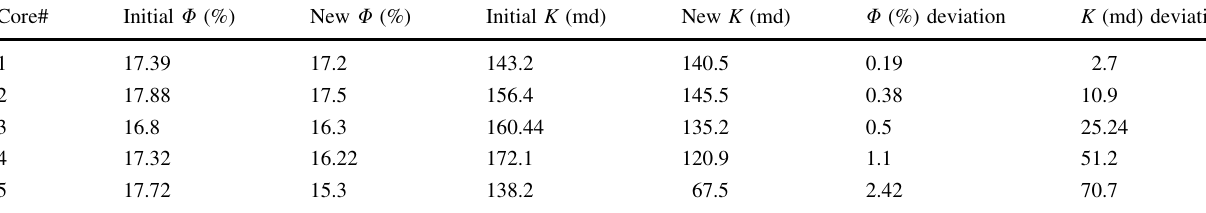
Table 9 Deviation in porosity and permeability after nano-flooding